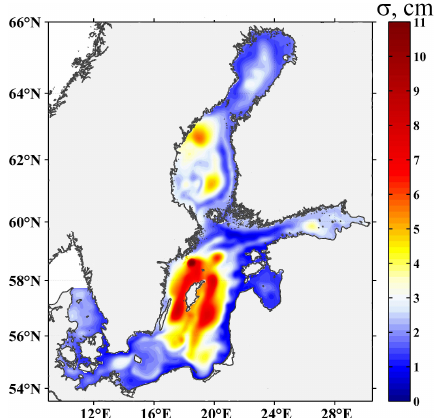
Figure 10. Sea level standard deviation ( σ ) for free oscillations in the baroclinic sea, simulated using